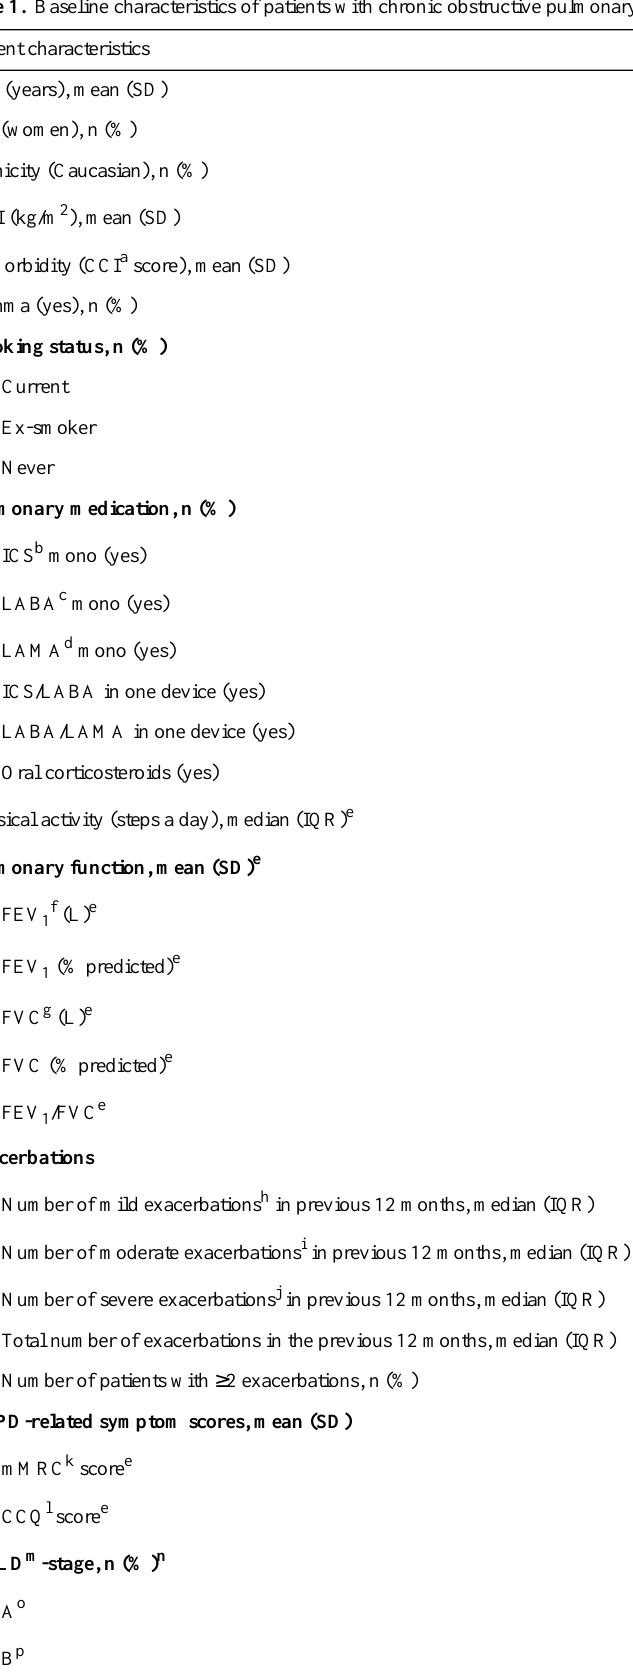
Table 1. Baseline characteristics of patients with chronic obstructive pulmonary disease (COPD;